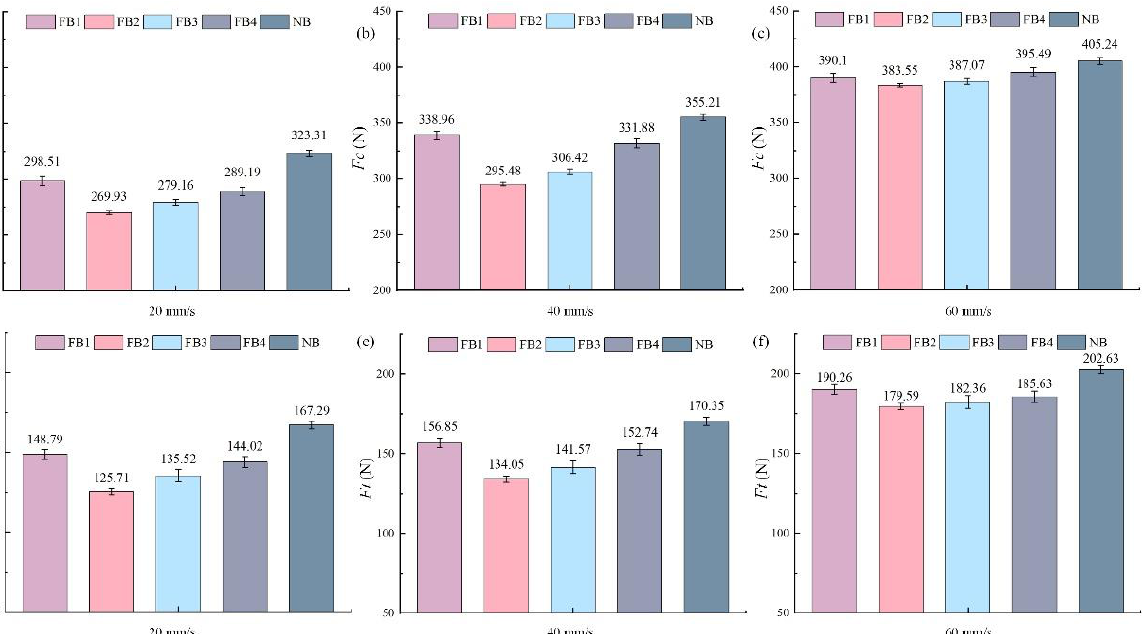
Figure 5. Broaching force by different tool surfaces at three cutting speeds: ( a – d ) cutting force ( F c ) at 20 – 60 mm/s.; ( d – f ) positive pressure ( F t ) at 20 – 60 mm/s. 20–60 mm/s.; ( d – f ) positive pressure ( F t ) at 20–60